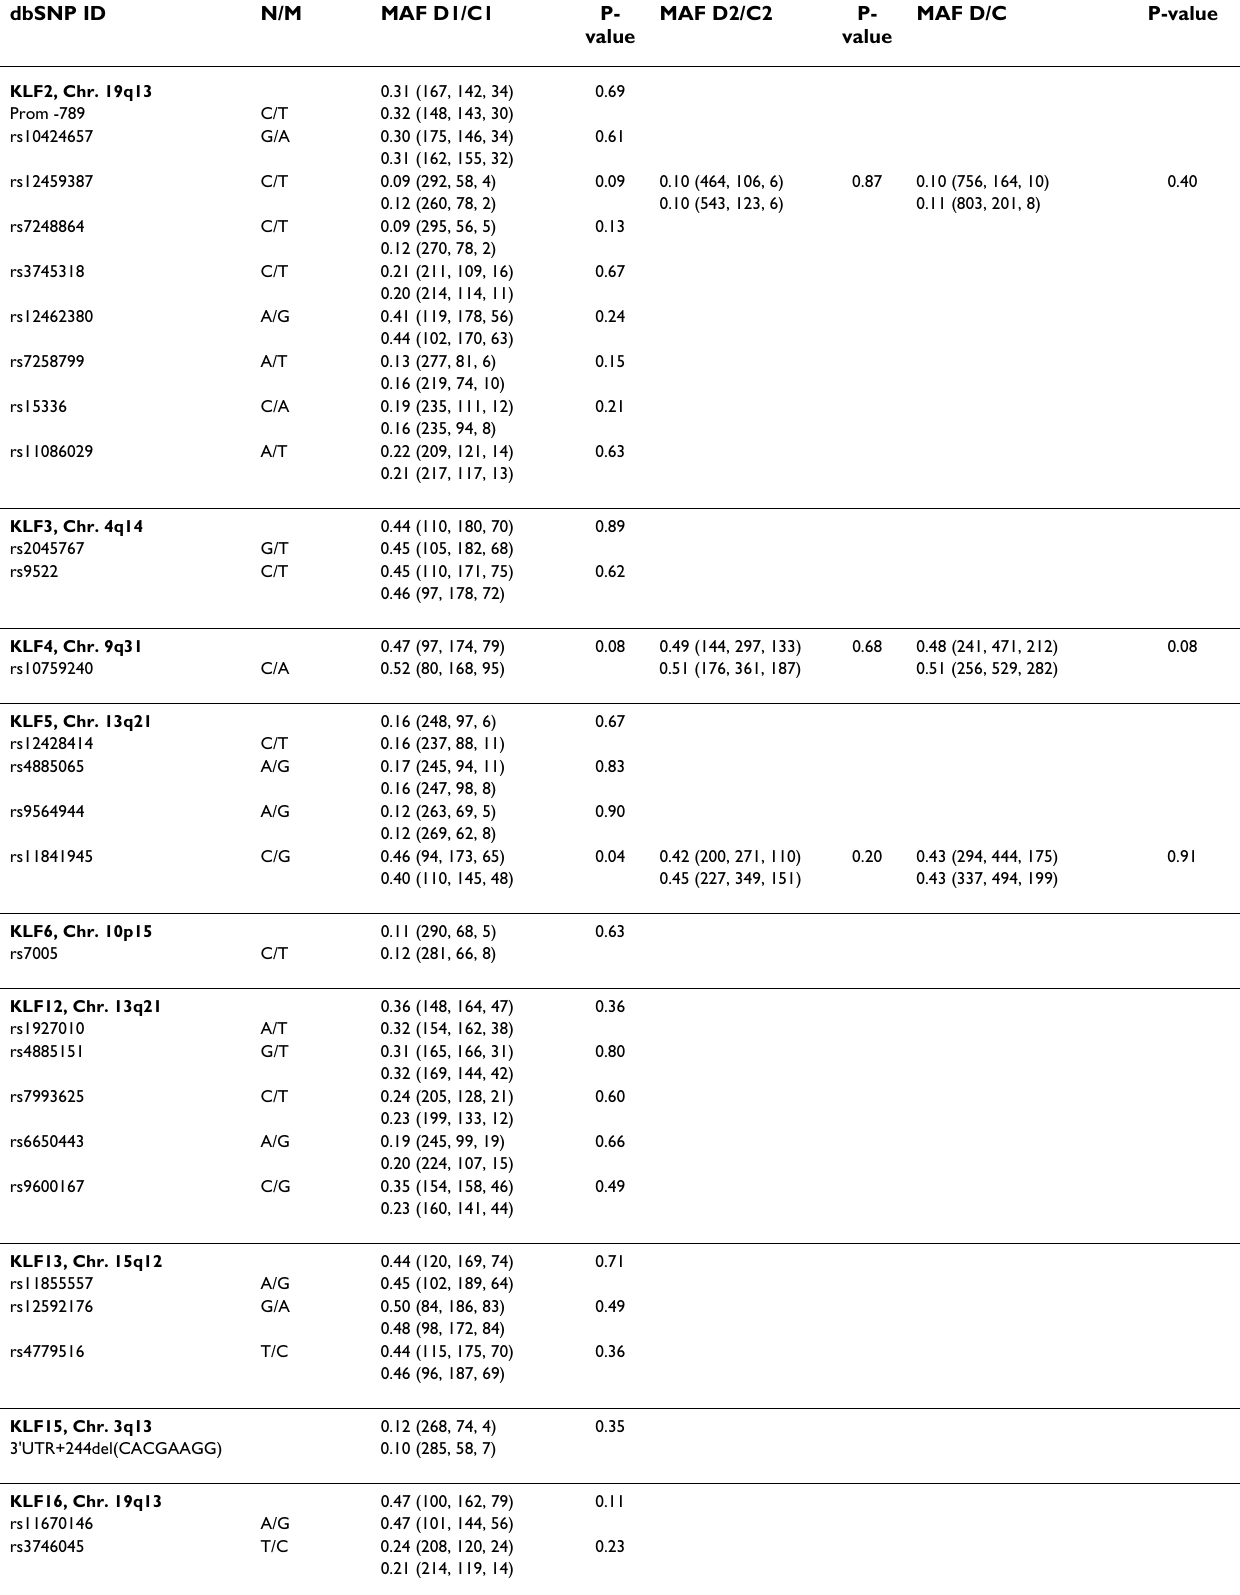
Table 2: Genotypic distribution of KLF SNPs in type 2 diabetic and non-diabetic